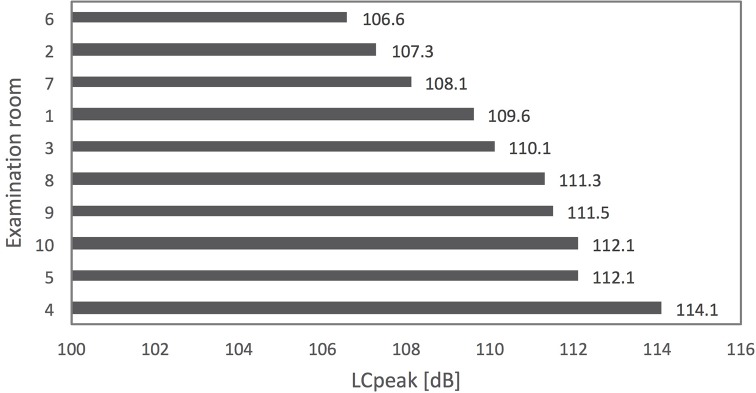
Peak sound levels (LCpeak) in examination rooms.